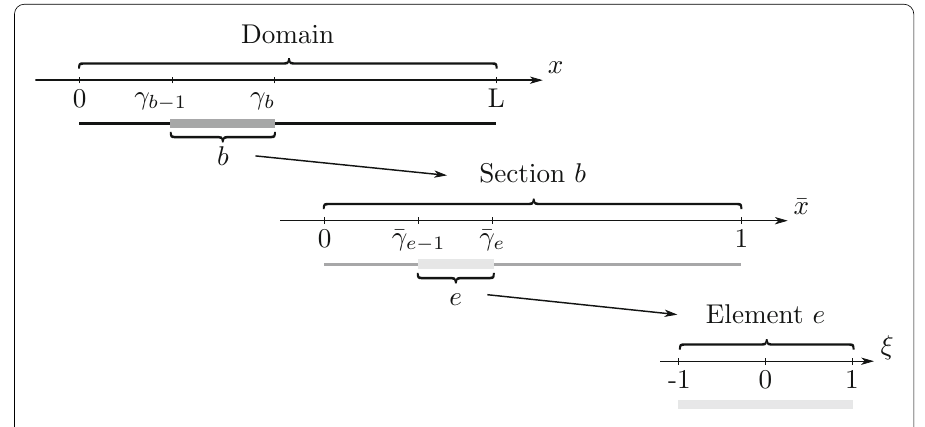
Fig. 2 Geometric mappings: from bar domain to section and from section domain to